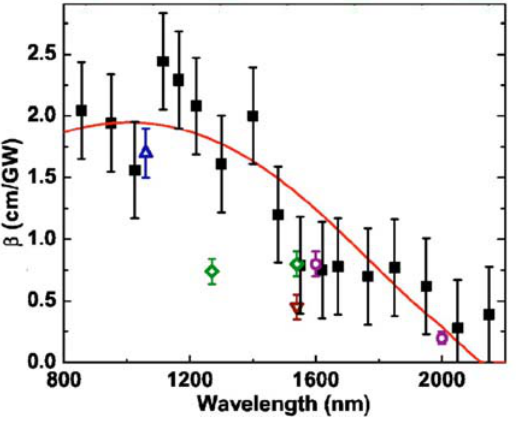
Figure 5. Measured value of β (squares) as a function of wavelength for a 125-µm-thick sample silicon wafer [43]. Data from other sources is also given: circles [44], up triangles [37], down triangles [39], and diamonds [41]. The solid curve represents the best fit based on calculations of Garcia and Kalyanaraman [45]. Reprinted with permission from A.D. Bristow, et al. [43]. (2007) . Copyright 2007, American Institute of